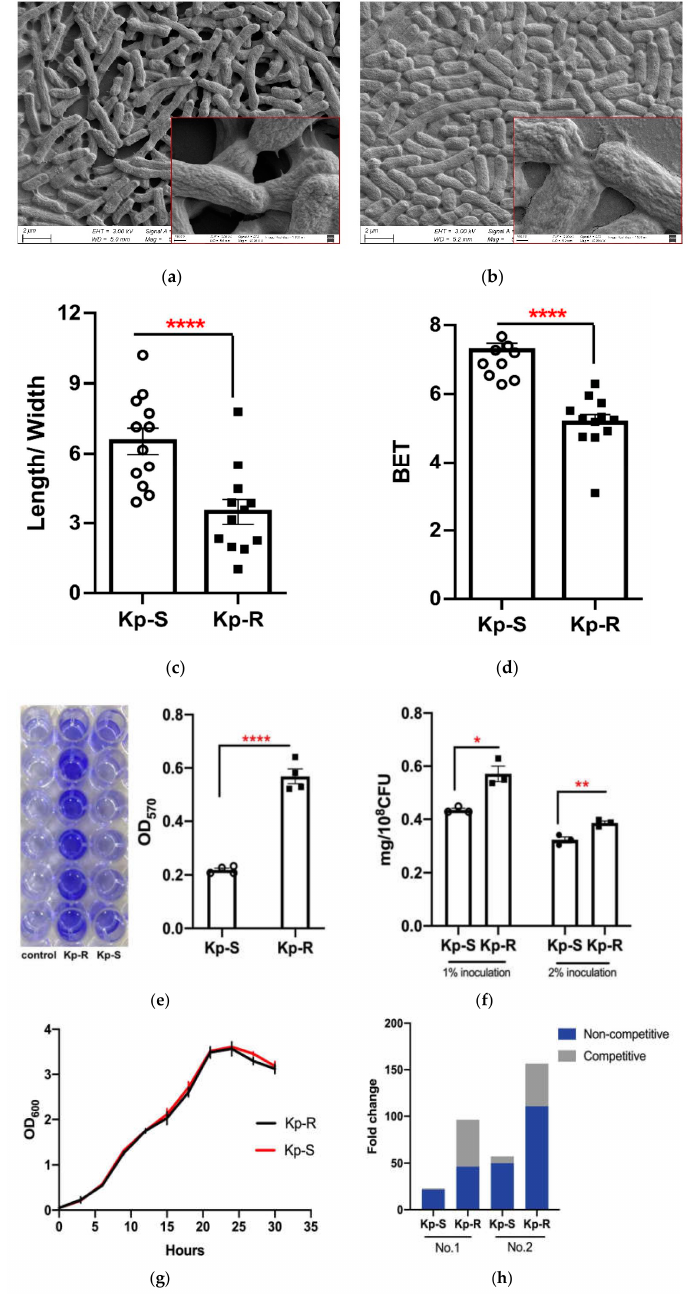
Figure 1. Bacterial morphology, biofilm-formation assay, CPS quantification, growth kinetics and proliferation rates under single or co-culture of Kp-S and Kp-R. ( a ) SEM image of Kp-S. ( b ) SEM